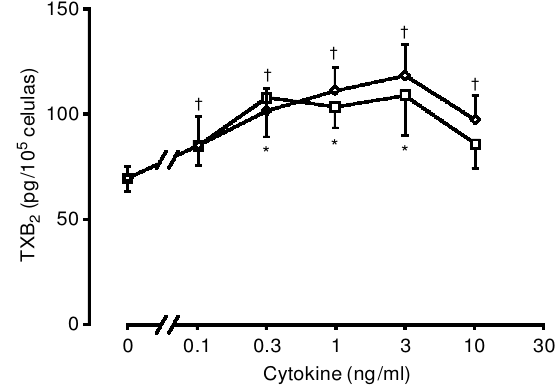
FIG. 2. TXB 2 production induced by IL-1 b (0.1 ± 10 ng / ml) (open squares) or TNF- a (0.1 ± 10 ng / ml) (open diamonds), for 4 h, from guinea-pig alveolar macrophages. Asterisks indicate the statistical signi® cance to IL-1 b and daggers to TNF- a . P , 0.05, † P , 0.05, compared with the control (0). n > 6.